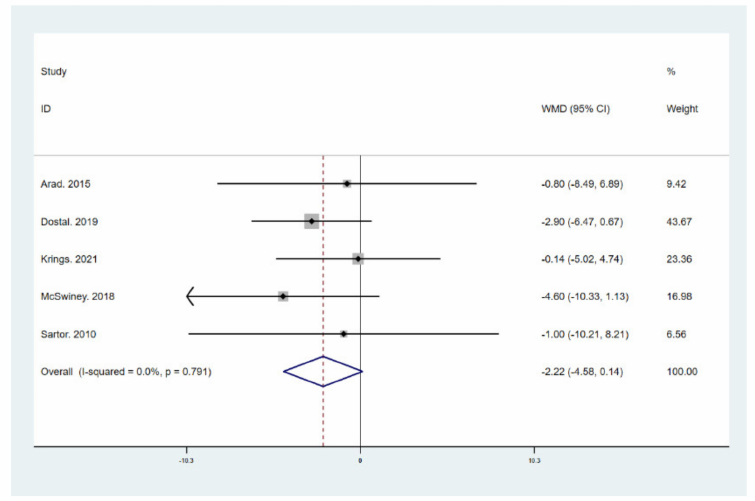
Figure 8. Forest plot for the effect of a low-carbohydrate high-fat (LCHF) diet combined with HIIT on fat mass (FM). For each study, squares represent the mean difference in intervention effects, with horizontal lines intersecting them as the lower and upper limits of the 95% CI. The size of each square represents the relative weight of the studies conducted in the meta-analysis. The diamond represents the results of the meta-analysis combining the individual